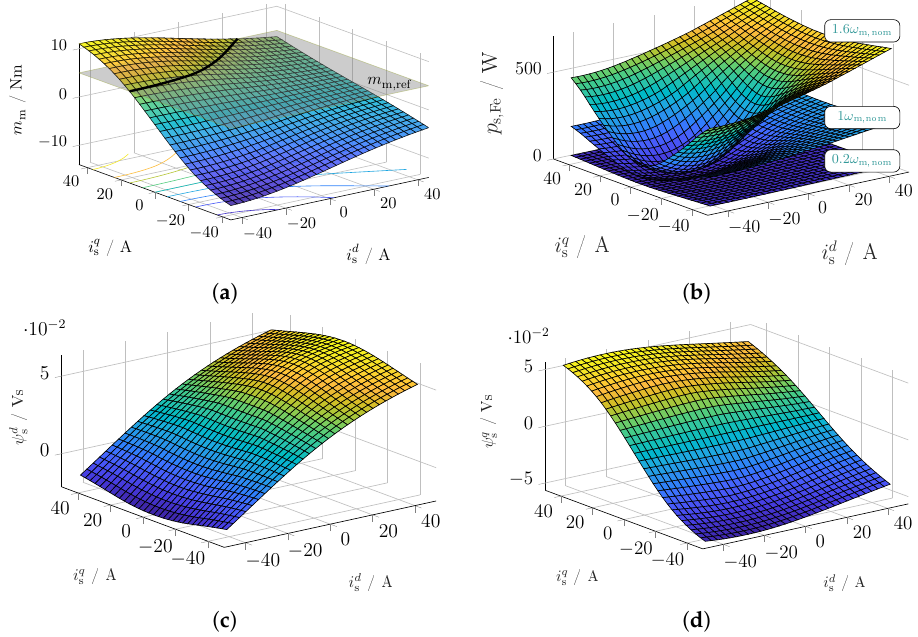
Figure 4. Illustration of machine torque, iron loss and flux linkage nonlinearities of a 4kW IPMSM (losses are shown for different speeds). ( a ) Nonlinear machine torque. ( b ) Nonlinear iron losses. ( c ) Nonlinear d -flux linkage. ( d ) Nonlinear q -flux